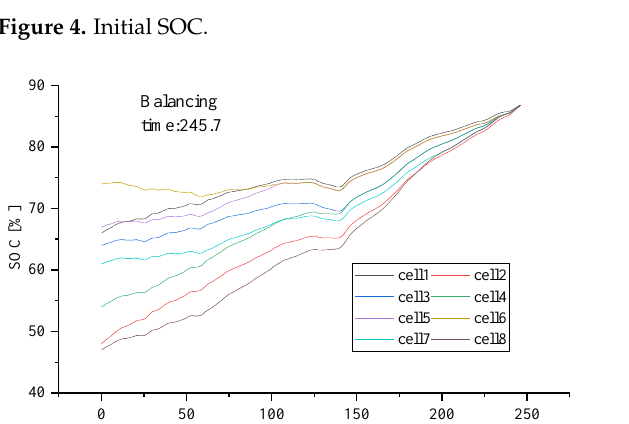
Figure 4. Initial SOC.